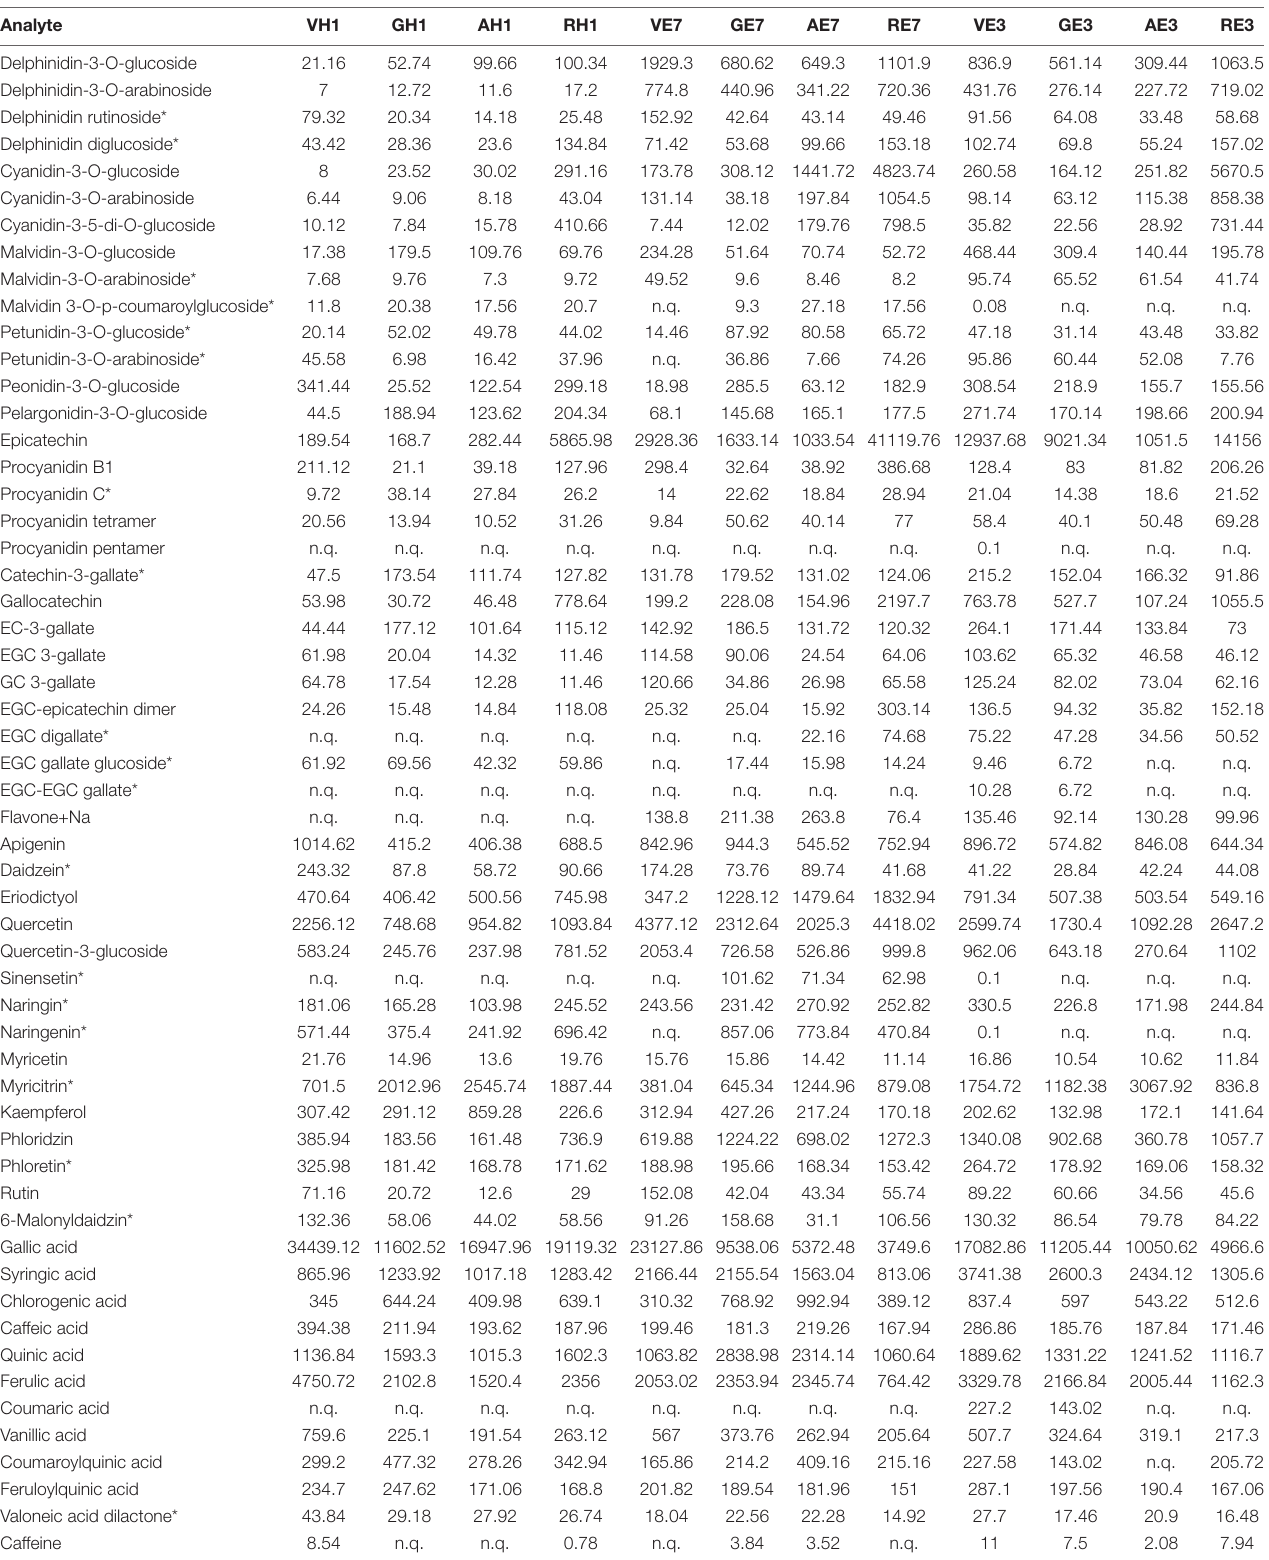
TABLE 6 | Metabolites identified in A. unedo fruit extracts by LC-MS/MS analysis (expressed in ng · g − 1 of FW).